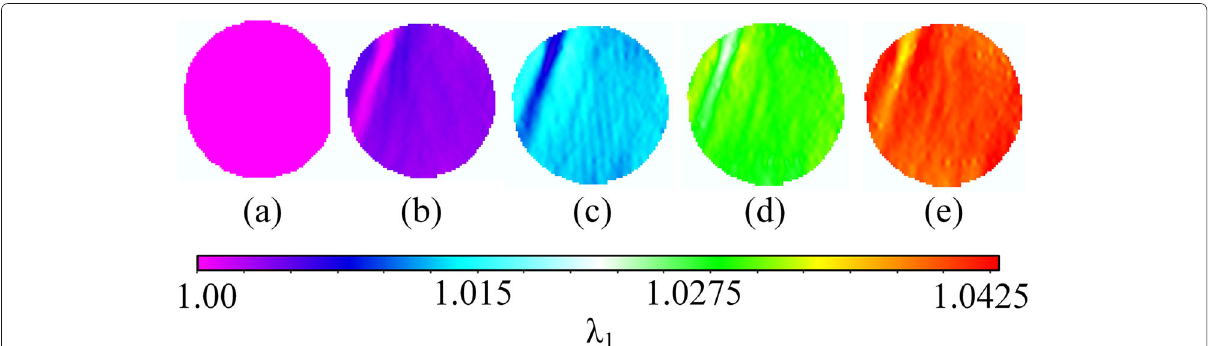
Fig. 13 Stretch field of λ 1 over the selected region at a 0 mm displacement, b 5 mm displacement, c 10 mm displacement, d 15 mm displacement and e 20 mm displacement of the flange fixture